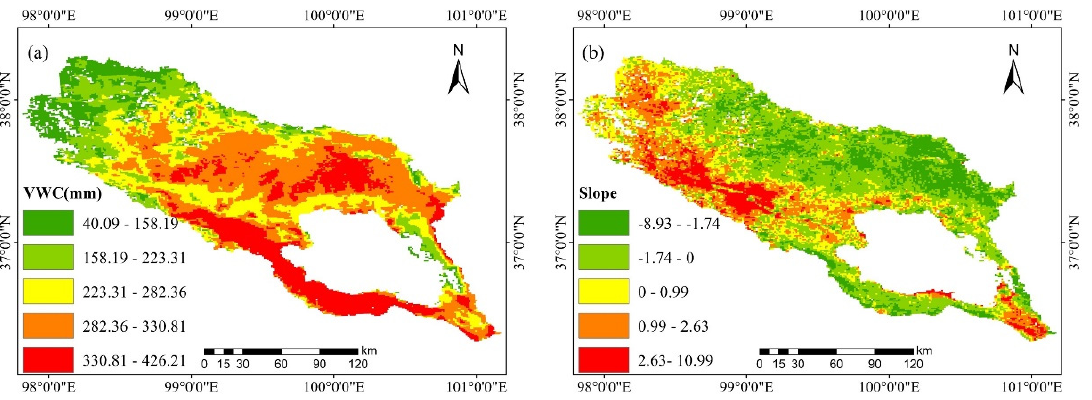
Figure 4. Spatial characteristics ( a ) and changing trends ( b ) of the VWC in the Qinghai Lake Basin from 2000 to 2014.